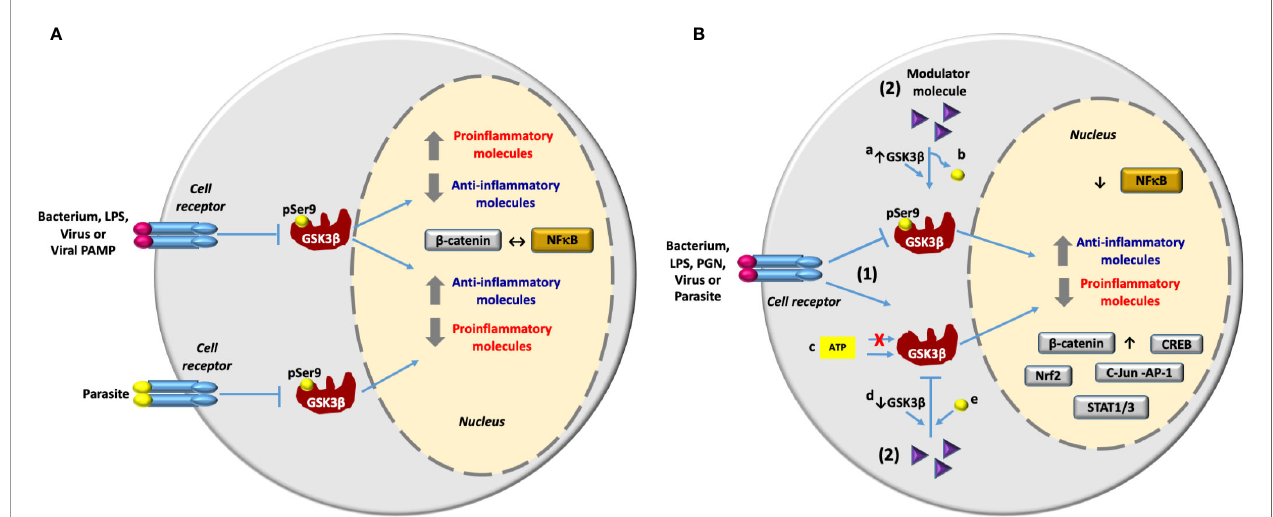
FIGURE 2 | GSK3 b in the in fl ammatory response activated by bacteria, viruses and parasites infection and lipopolysaccharide and viral PAMP stimulation. (A) An infectious stimulus can induce the inhibition of GSK3 b through phosphorylation at Ser9. Consequently, depending mainly on the infectious stimulus, the expression of proin fl ammatory molecules can be inhibited or increased. The in fl ammatory response is carried out through the activation of the transcriptional factor NF- k B and the anti-in fl ammatory response is carried out through the activation of b -catenin. So that the activation of NF- k B inhibits the activation of b -catenin and vice versa ( ↔ ). (B) Inhibition of in fl ammation induced by infectious stimulus through modulation of GSK3 b activity with different molecules. 1) An infectious stimulus induces in fl ammation through the inhibition or activation of GSK3 b . 2) Molecules with different structural nature are able to control the in fl ammation modulating de activity of GSK3 b by different mechanisms: By induction of a) the increase in GSK3 b expression or b) dephosphorylation at Ser 9 [GSK3 b activation] and by c) ATP-competitive and ATP-noncompetitive inhibition or by induction of d) the reduction in GSK3 b expression, or e) phosphorylation at Ser9 [GSK3 b inhibition]. Reduction in the expression of proin fl ammatory molecules and the increase in the anti-in fl ammatory molecules expression are carried out by inhibition of the transcriptional factor NF- k B and the activation of transcriptional factors b -catenin, Nrf2, CREB, cJun-AP1 and